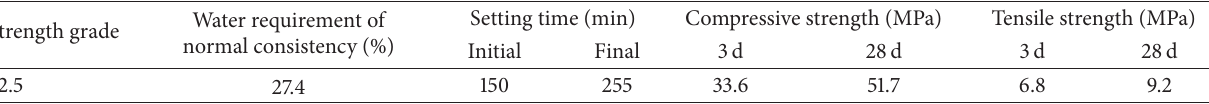
Table 1: Physical and mechanical properties of cement.